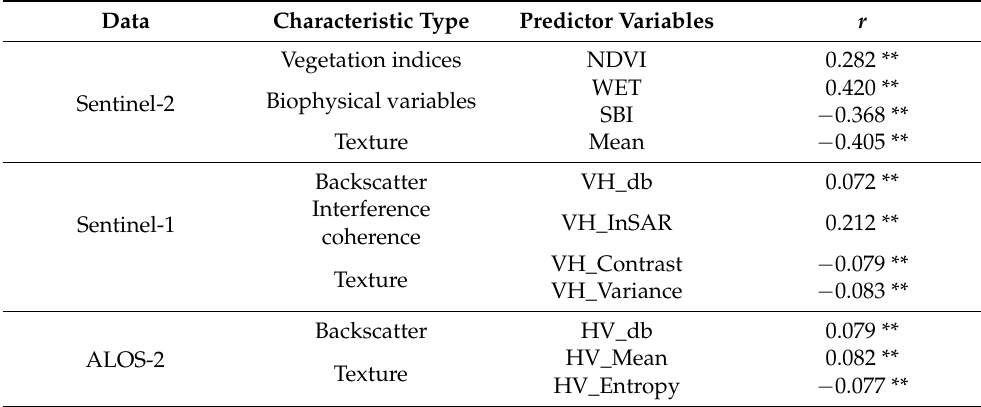
Table 4. Selected predictors derived from remote-sensing data and correlation coefficient with AGB (“**” denotes that the p < 0.01).